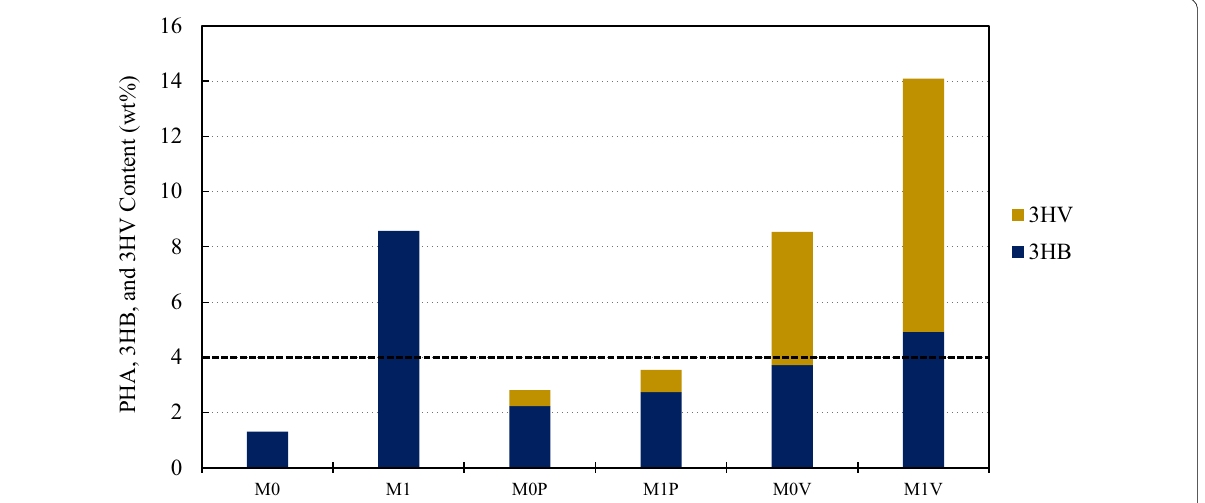
Fig. 4 PHA content presented in fractions of 3HB (blue filled square) and 3HV (yellow filled square) on a mass basis (wt%). The content and composition of PHA was obtained at the end of the PHA accumulation phase in the presence and absence of methane. A bold dotted line represents the initial PHA content in the culture before subjected to PHA